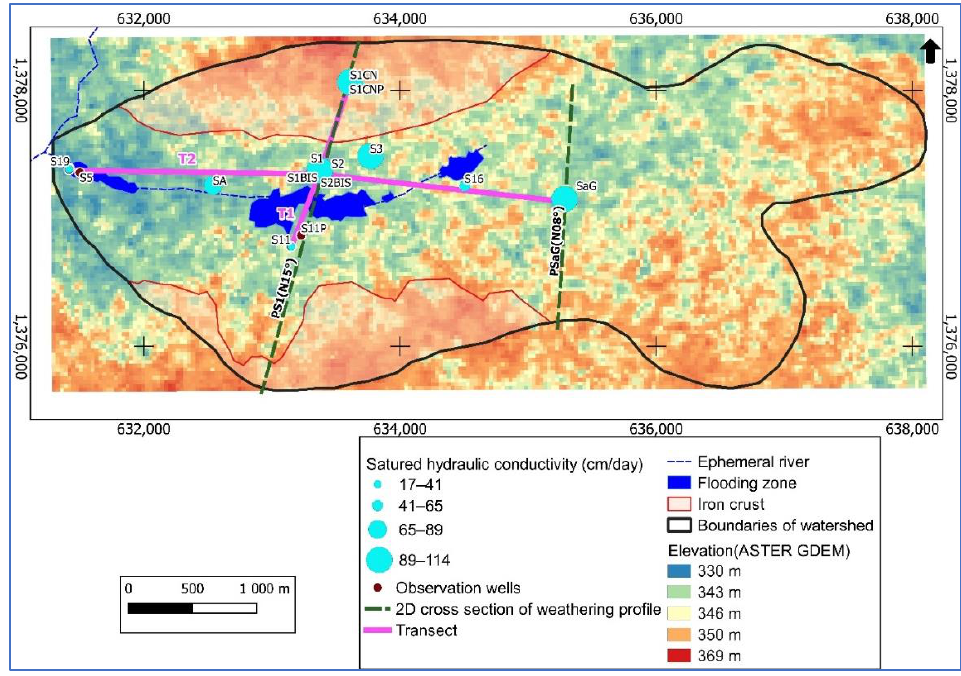
Figure 5. Classes of saturated soil hydraulic conductivity Ksat according to the position of the piezometers. Table 2. Average values of electrical conductivity according to aquifer type.